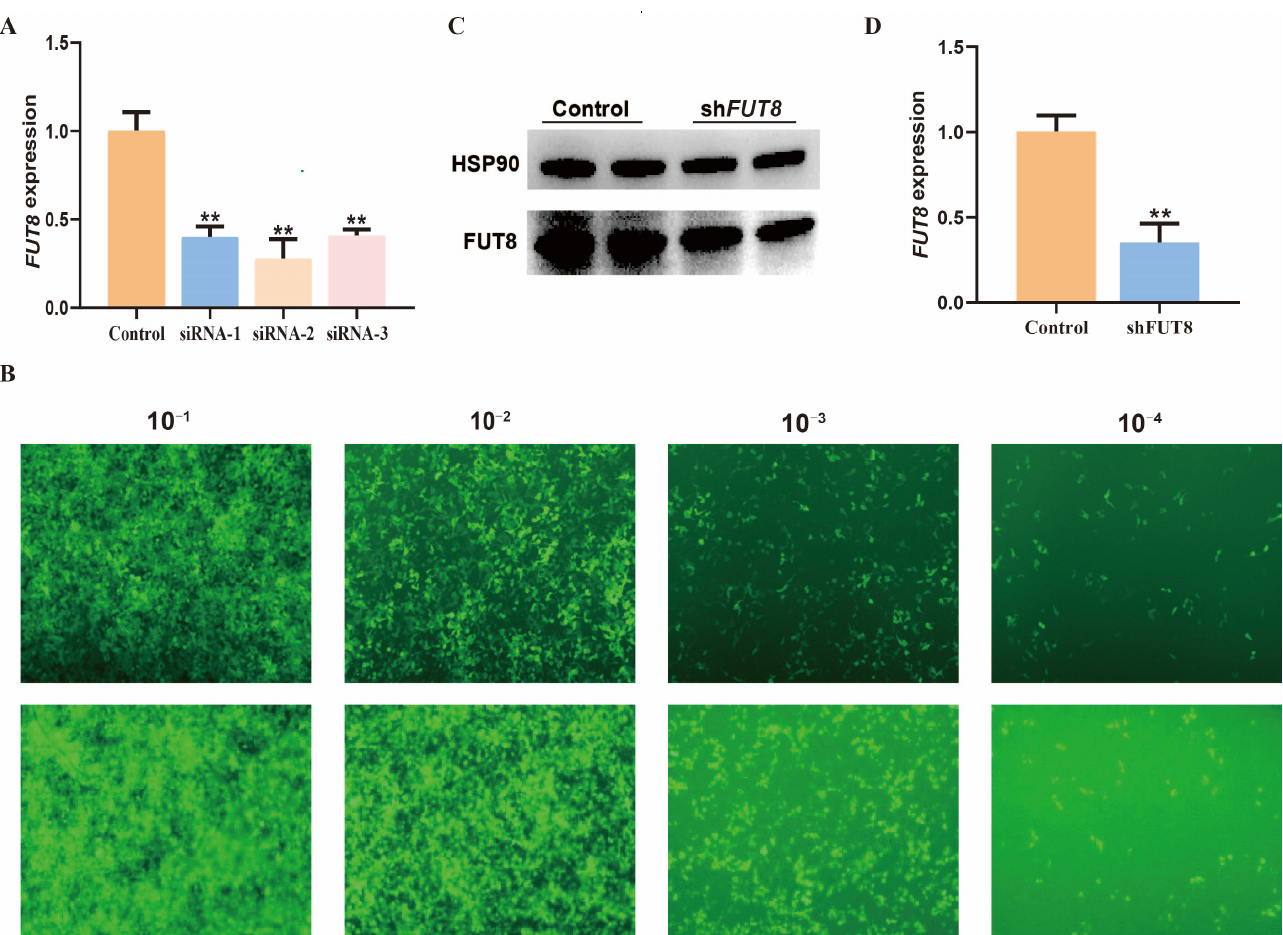
Figure 2. Establishment of cell lines with FUT8 interference. ( A ) The interference efficiency of siRNA on the FUT8 gene within IPEC-J2 cells. ( B ) Detection of lentiviral titer (24 h, 40×). ( C , D ) Knockdown efficiency of the FUT8 gene in shFUT8 cells, which was determined using Western blotting ( C ) and RT-qPCR ( D ) tests. ** p < 0.01.